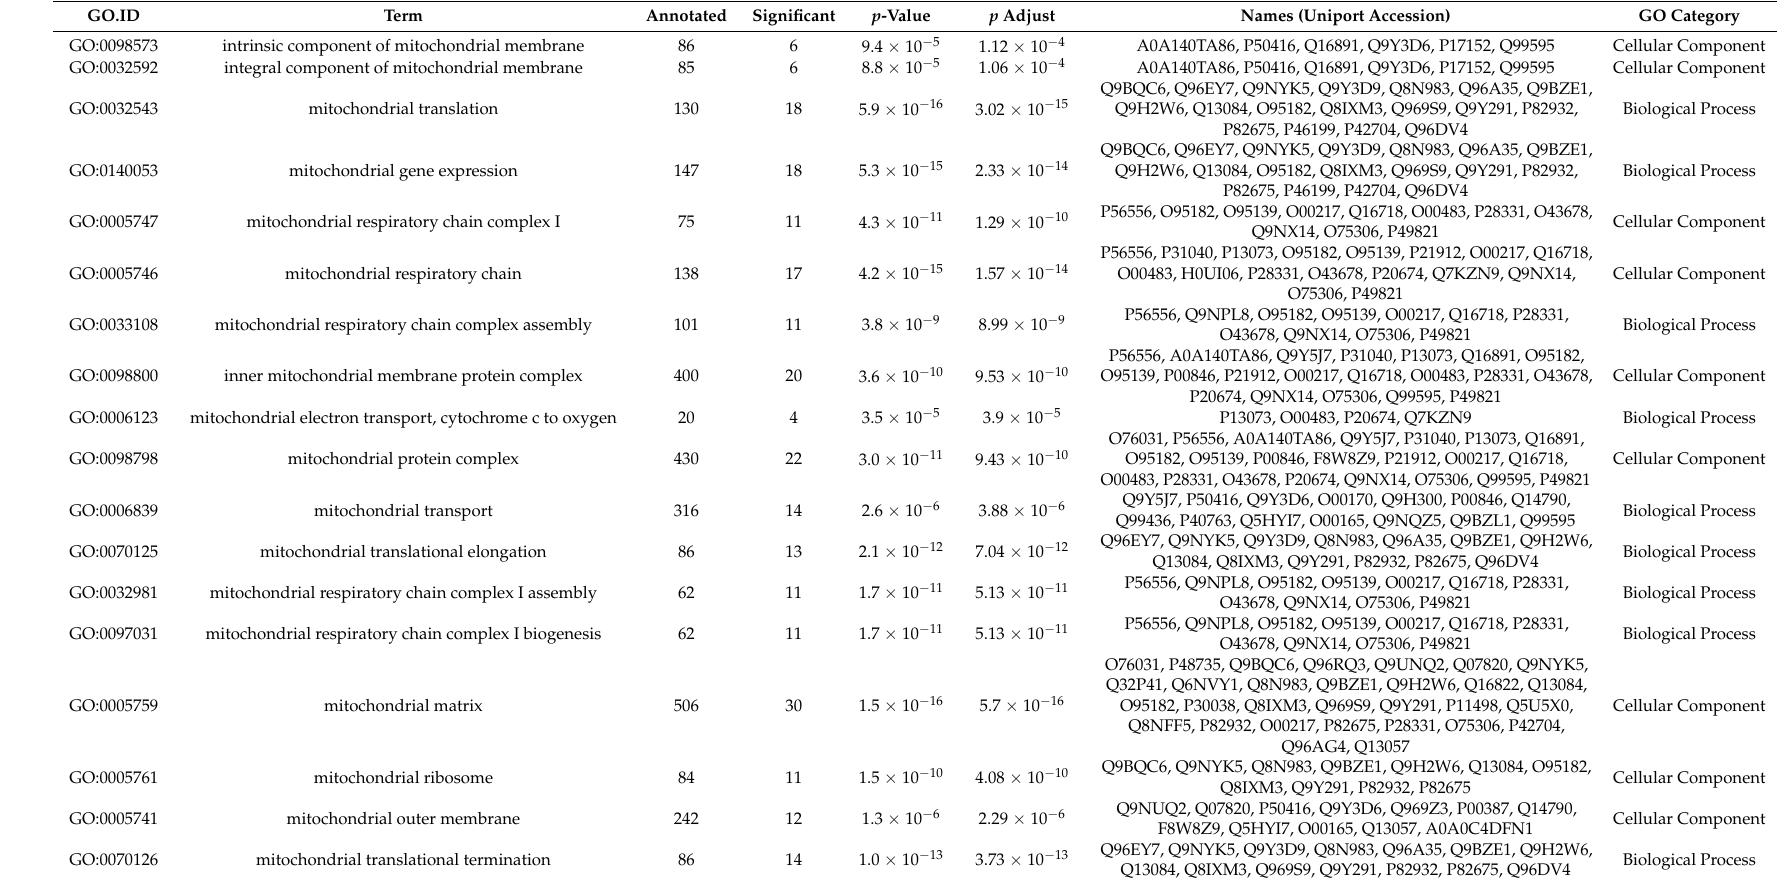
Table 1. Representative results of GO enrichment analysis related to mitochondria